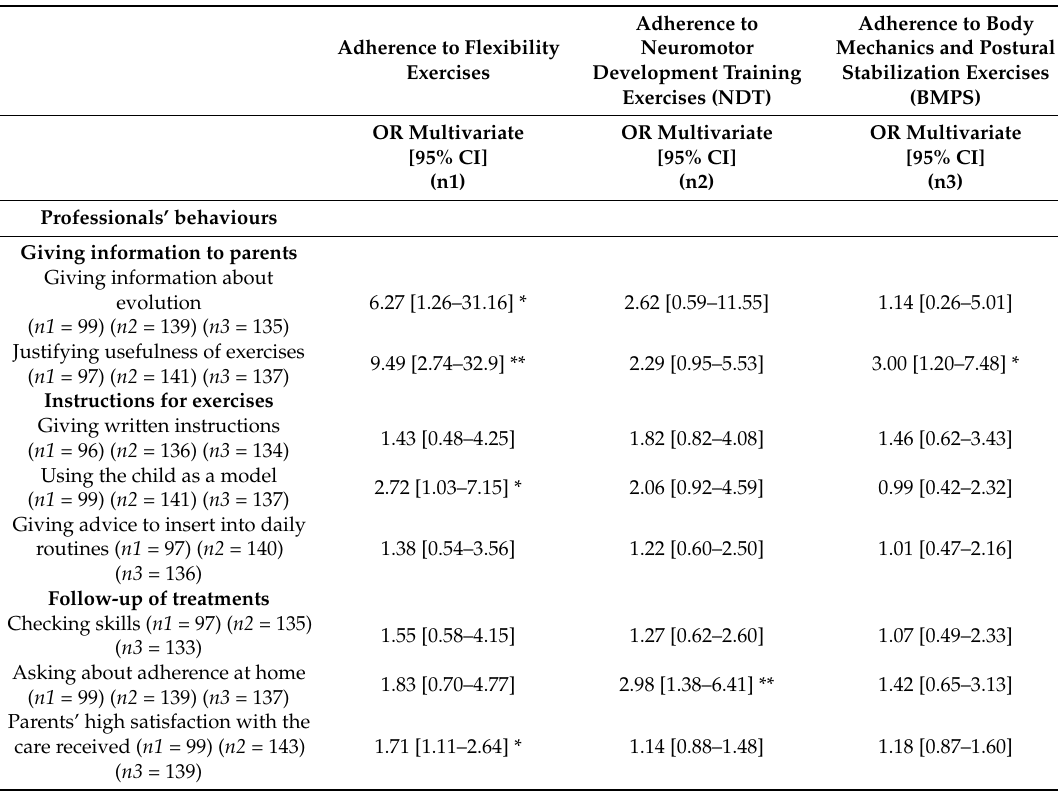
Table 3. Adjusted Odds Ratio of professionals’ behaviours predictive of adherence to specific types of exercises featured in the home exercise